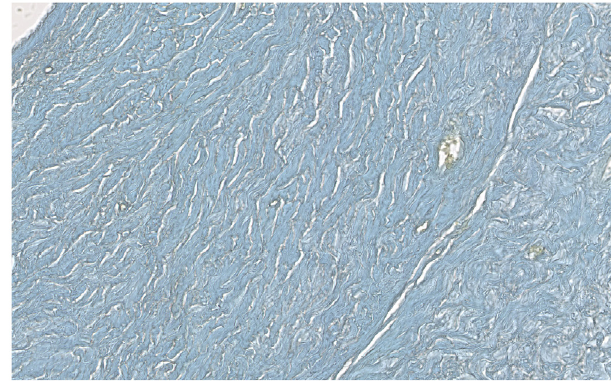
Figure 5. Human ovary histochemistry. Absence of Gram positive granules in the ovary (×20).